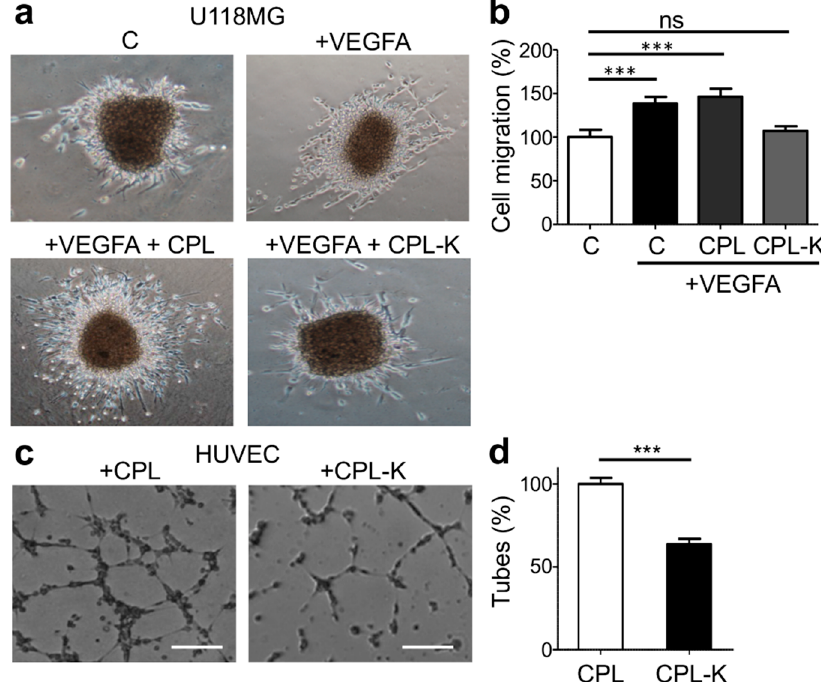
Figure 4. CPL-K inhibits cell migration and angiogenesis. ( a , b ) Phenotype ( a ) and quantification ( b ) of U-118MG cell migration in a 3D coagulated chicken plasma matrix after 24 hours of culturing the cell aggregate. Results are normalized to the cell migration observed in medium without VEGFA. The relative surface of migration (%) was determined with Image J. N = 3 independent experiments, 5–30 explants measured per condition for each experiment. *** p < 0.0001 ** p < 0.001 Mann-Whitney test. ( c , d ) Phenotype ( c ) and quantification ( d ) of human umbilical vein endothelial cell (HUVEC) tubulogenesis on Matrigel 4 hours after seeding in complete medium. Scale bar, 200 µm. Results are normalized to tubulogenesis in the presence of CPL. Note a 37% decrease of tube formation with CPL-K. N = 9 independent experiments. *** p ≤ 0.0001; ns = not significant (Mann–Whitney test).